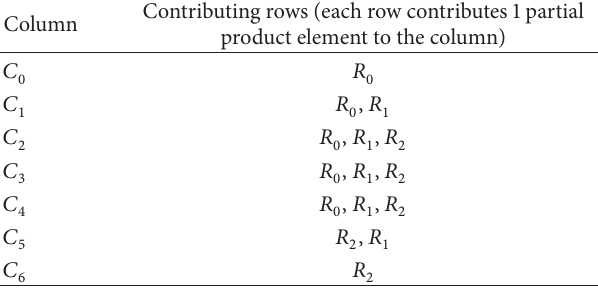
Table 7: Contributing rows for 𝑚 = 5 and 𝑛 = 3. Contributing rows (each row contributes 1 partial Column